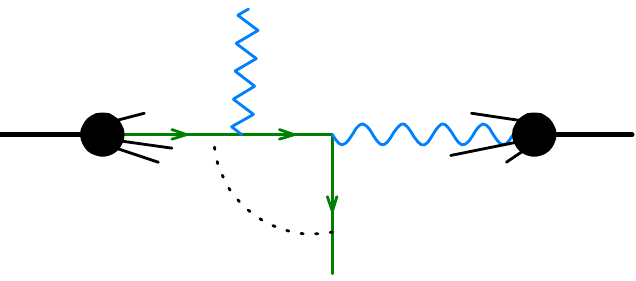
Figure 2 . A Born diagram for Z production in photon-quark collision. The incoming photon is represented by the blue wavy line. This process has an azimuthal asymmetric colour pattern of soft emission, and is suitable for testing for the presence of linear renormalons in the Z transverse momentum